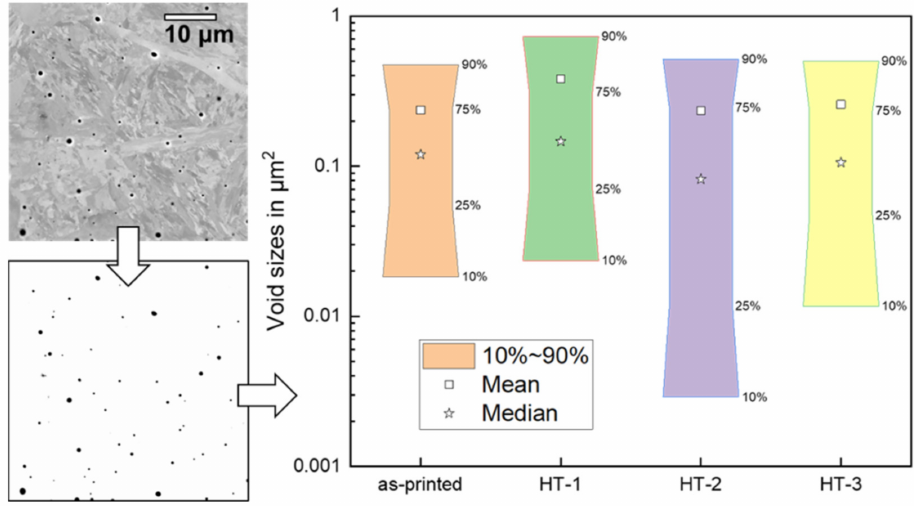
Figure 17. Porosity distribution in samples in as-fabricated and heat-treated